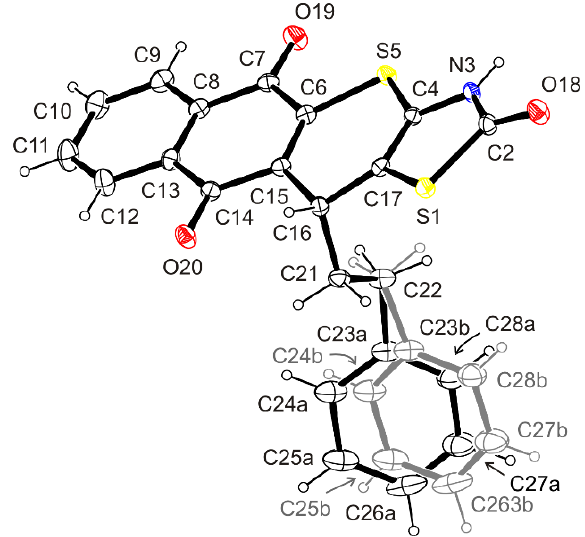
Figure 3. ORTEP view of the molecule of 3.6 showing the atomic labeling Scheme. Non-H atoms are drawn as 30% probability displacement ellipsoids and H atoms are drawn as spheres of an arbitrary radius.